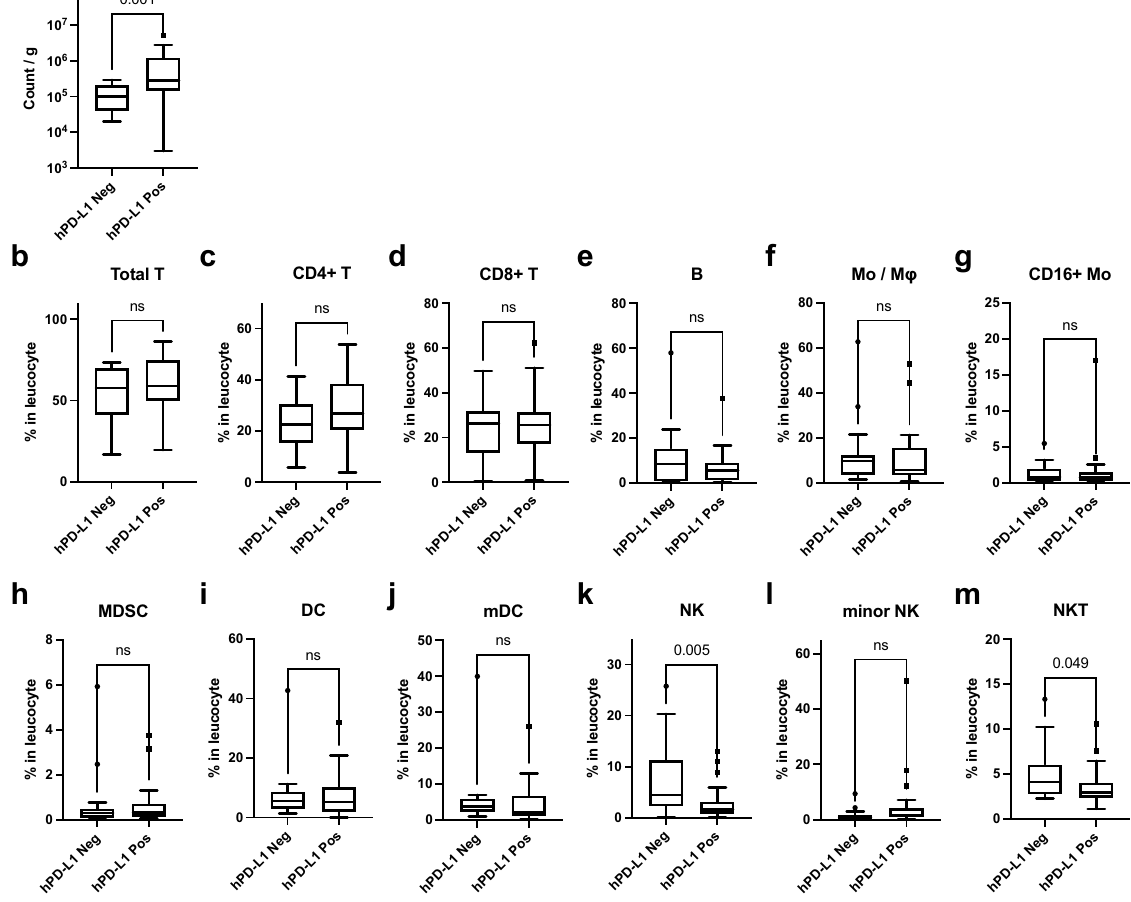
Figure 4. hPD-L1 positivity is associated with increased leukocyte infiltrations in the tumor tissue and partly with the immune cell composition. For cases with tumor tissue samples, ( a ) leukocyte densities (count/g) and ( b – m ) the percentages of the immune cell fractions in the tumor tissues were compared between the hPD- L1-negative cases and hPD-L1-positive cases using the Mann–Whitney U test. The data are presented using Tukey box plots. Values of P < 0.05 were considered statistically significant. The actual P -values are shown in the